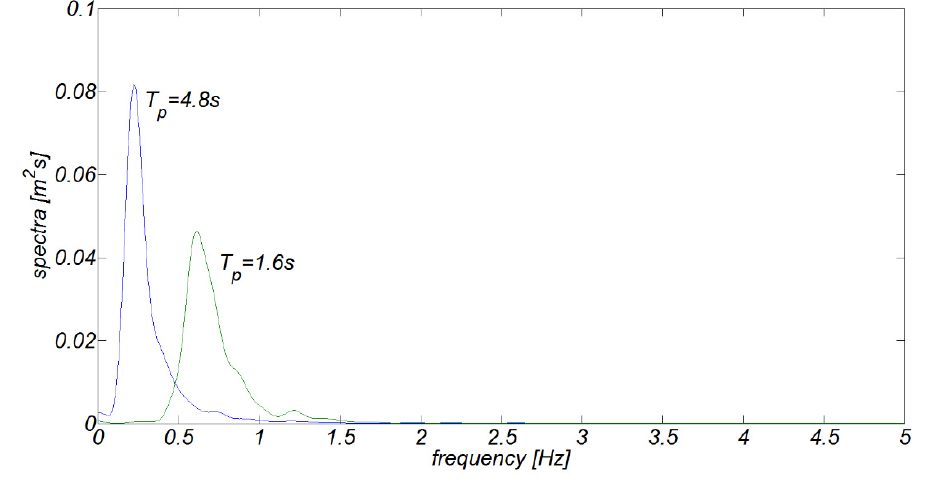
Figure 2. Measured wave spectra.